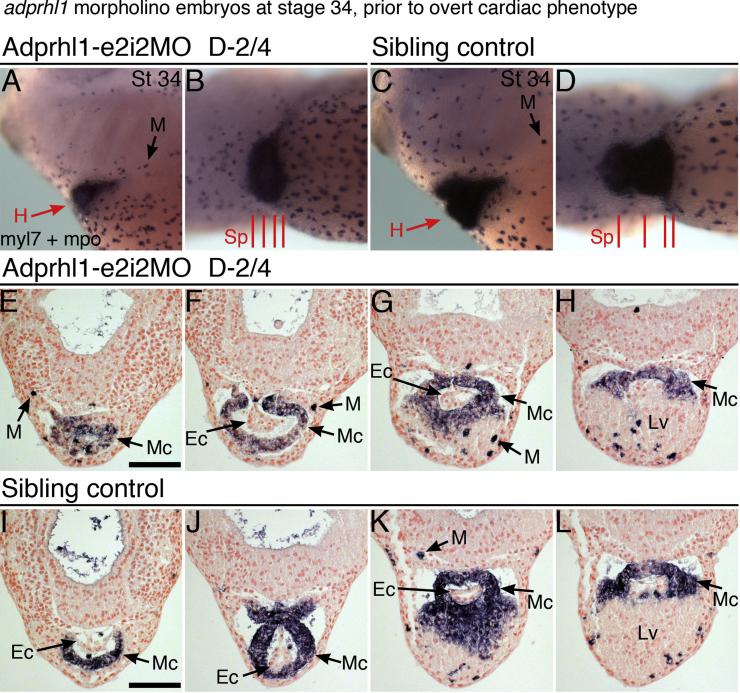
Adprhl1morpholino embryos at stage 34, prior to overt cardiac phenotype. A, B, E–H: The heart of a stage 34 embryo injected with Adprhl1-e2i2MO into D-2/4 blastomeres, before the cardiac phenotype becomes apparent. Expression of myl7 in the myocardium and mpo in migrating embryonic macrophages are shown in left lateral (A) and ventral (B) views. The red lines (B) mark the position of four transverse sections cut through the heart outflow (E), ventricle (F), atrial (G) and inflow regions (H). C, D, I–L: Comparable images of a sibling embryo. In this experiment, half the cohort of injected embryos were allowed to develop on to stage 40 to confirm the morpholino’s subsequent action on heart formation and function. The macrophage marker was included to prove that impaired endocardial development noted at later stages did not originate from defective macrophage migration from the heart-forming region. Stage 33–34 marks the onset of cardiac contractions in control embryos. The only difference noted in morpholino injected embryos was within the outflow region, which did not extend rostrally but rather occupied a dorsal position. Scale bars=100 µm. H, heart; M, macrophage; Sp, section position; Mc, myocardium; Ec, endocardium; Lv, liver.